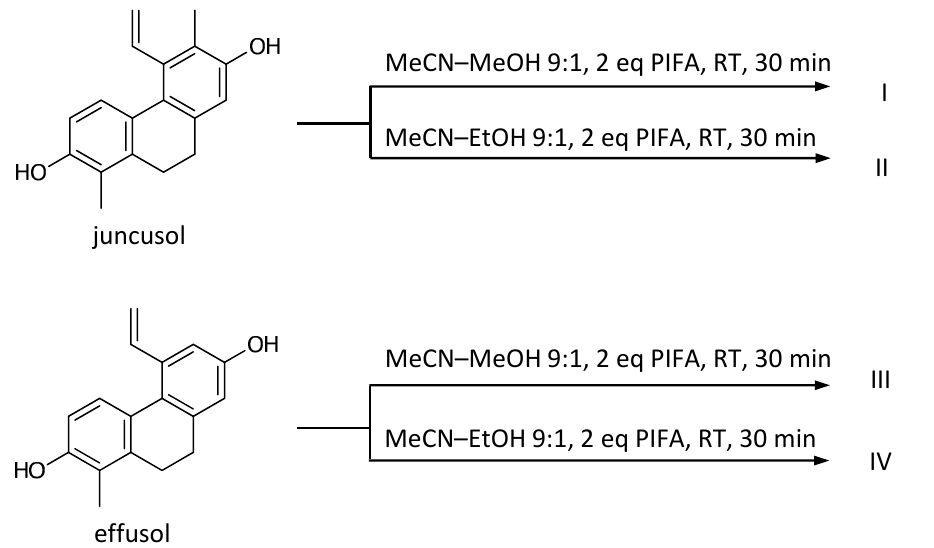
Molecules 2020 , 25 , x